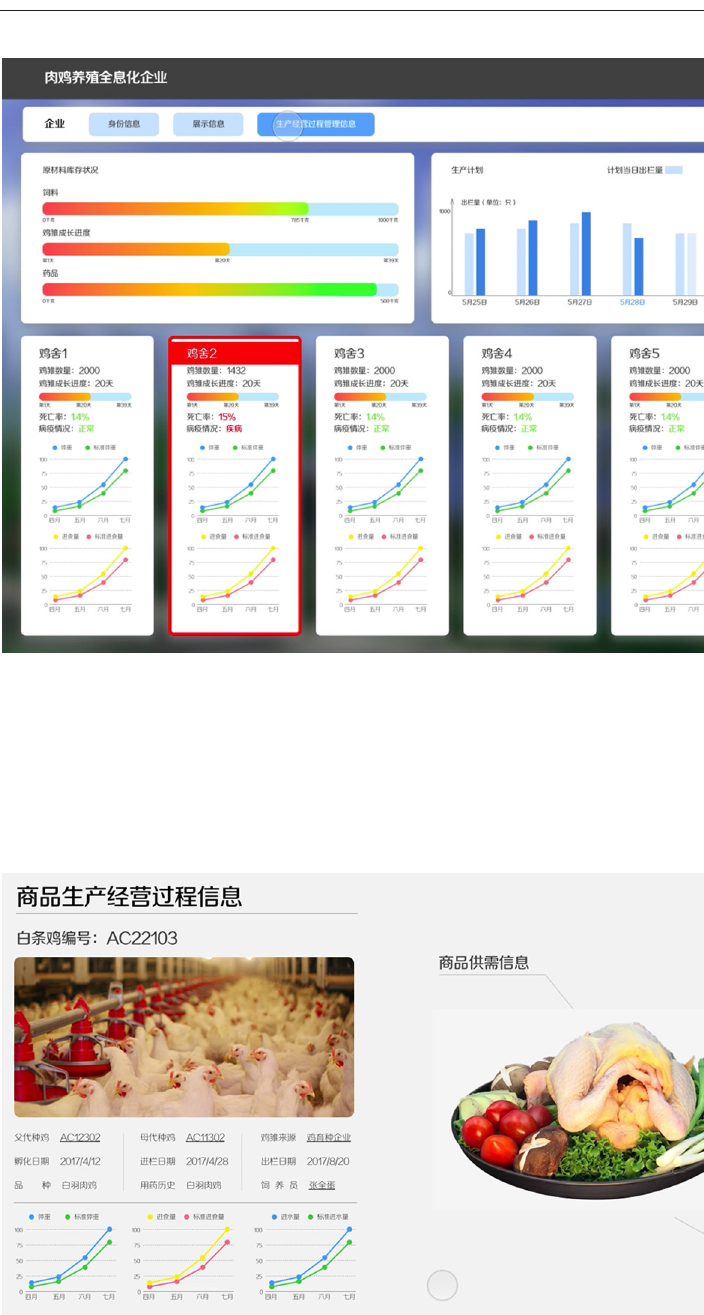
Figure 6. Production